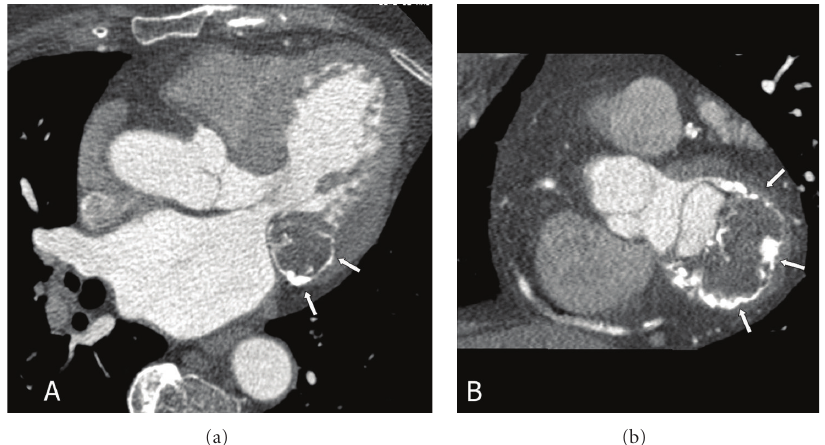
Figure 2: Cardiac CT, long axis (a) and short axis (b) views, showing a crescent-shaped hypodense mass with peripheral linear calcification that produces a shifting of posterior leaflet of mitral valve. No alterations of valvular function were